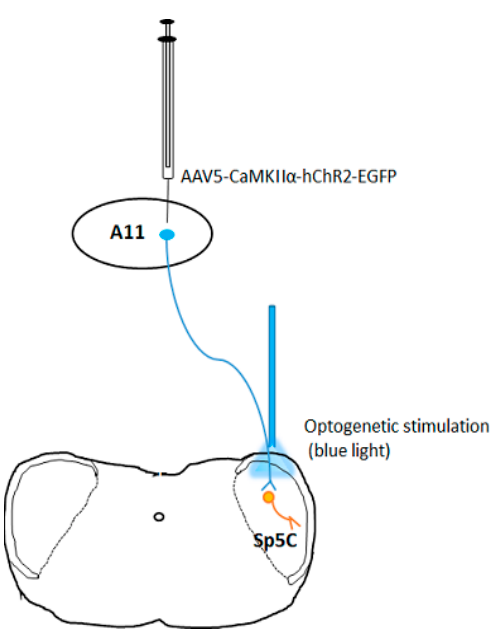
Figure 1. Optogenetic excitation of neuronal activity in the A11-Sp5C pathway. Stimulation frequency and duration are critical factors in optogenetic